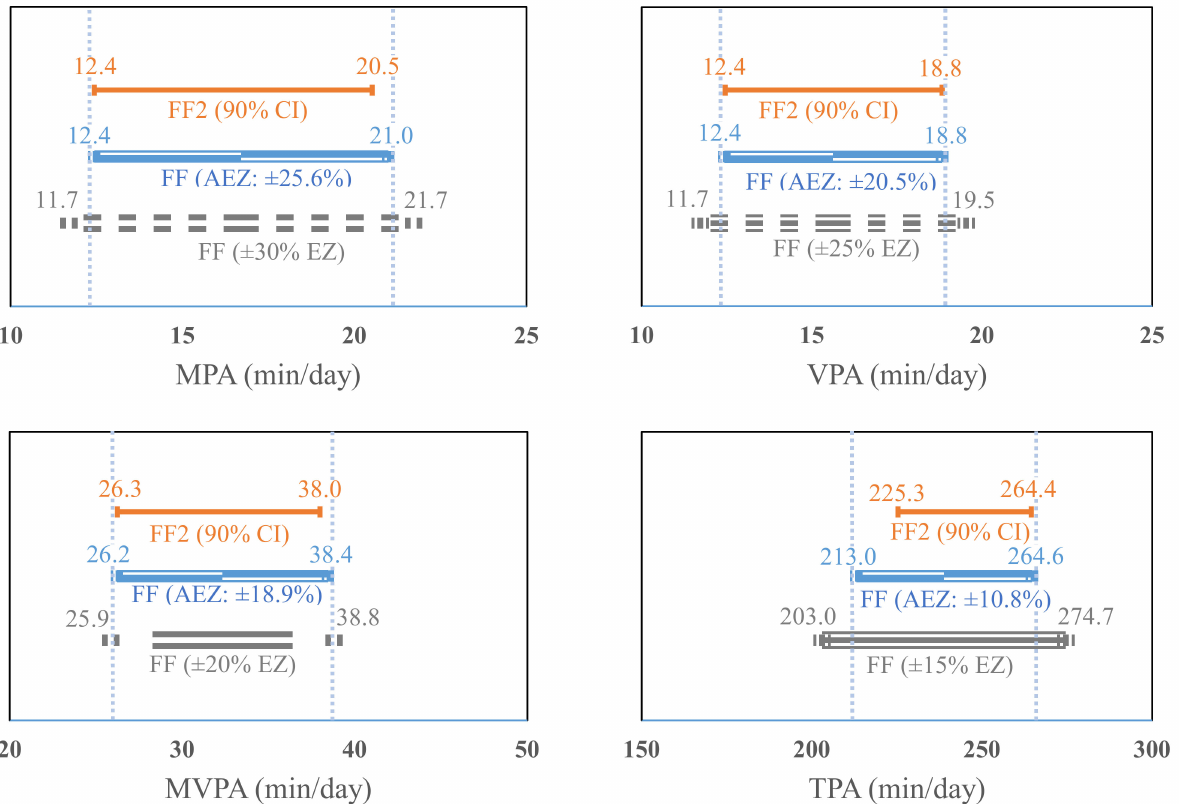
Figure 3. Equivalence testing for SED and PA. CI: Confidence interval; AEZ: Actual equivalence zone; EZ: Equivalence zone; SED: Sedentary behavior; LPA: Light physical activity; MPA: Moderate physical activity; VPA: Vigorous physical activity, MVPA: Moderate-to-vigorous physical activity; TPA: Total physical activity; Vertical dashed lines show the actual bounds within which the FF2 is statistically equivalent to the FF for SED and PA